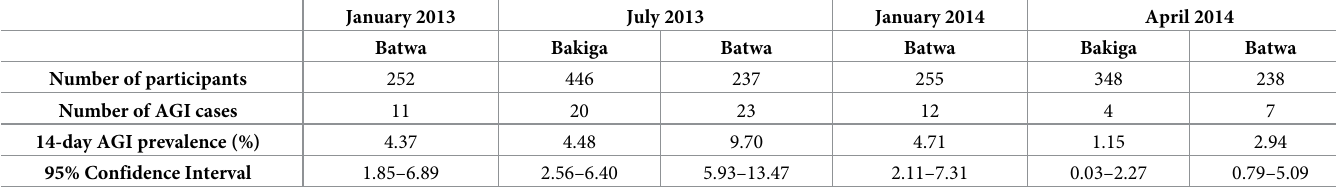
Table 1. Acute gastrointestinal illness (AGI) cases � for Batwa and Bakiga over 18 years old in southwestern Uganda (2013–2014).